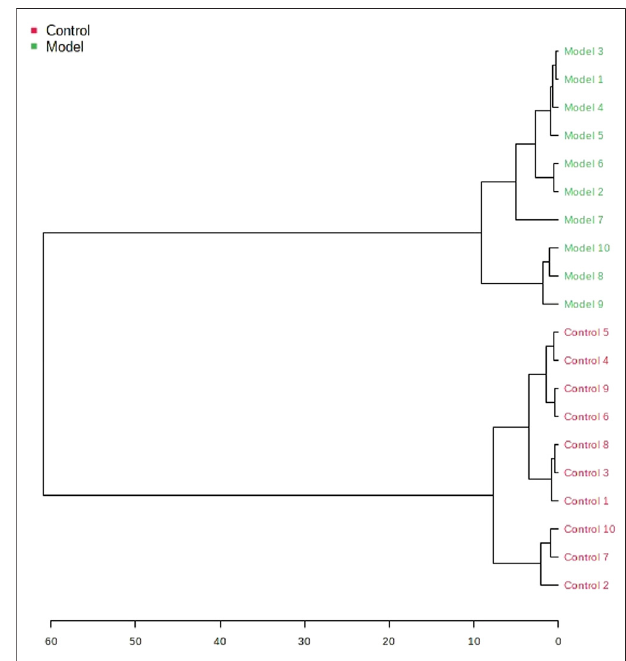
FIGURE 1 | Metabolic pro fi le characterization of PCA score plots for the control and model groups.